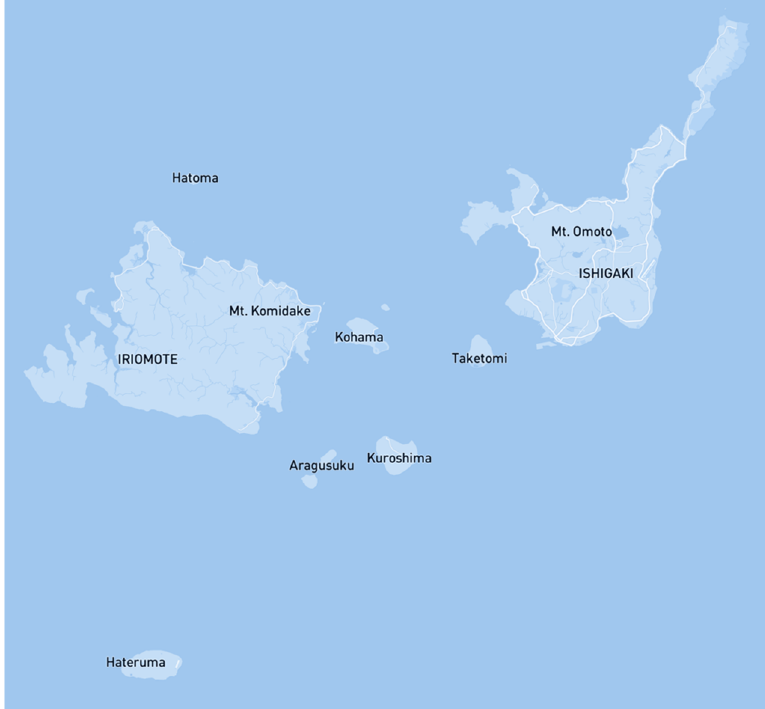
Figure 1. Map of the Yaeyama Islands © Mapbox, © OpenStreetMap.